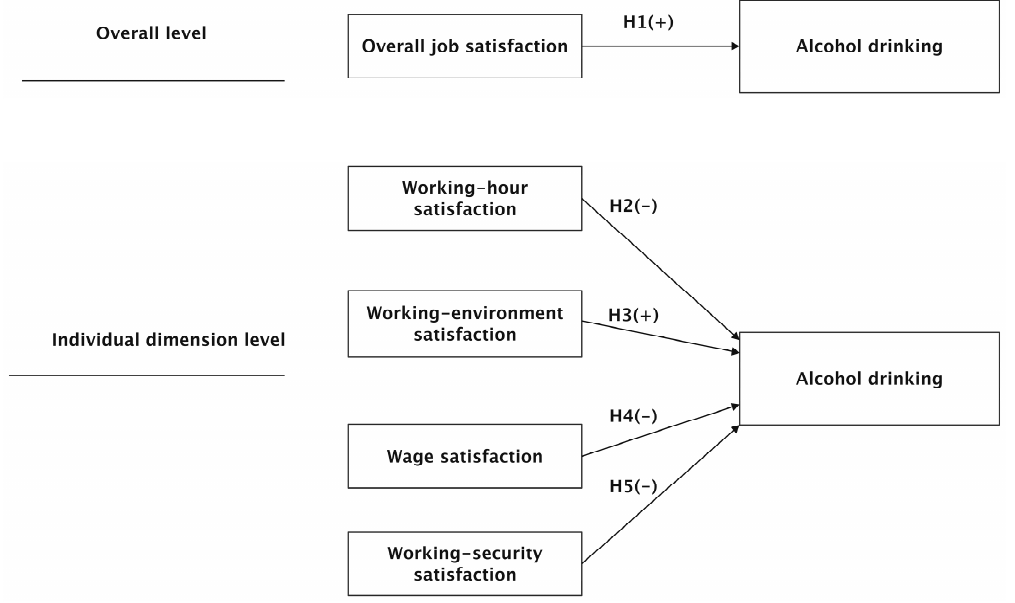
Figure 1. The theoretical framework and related hypotheses.